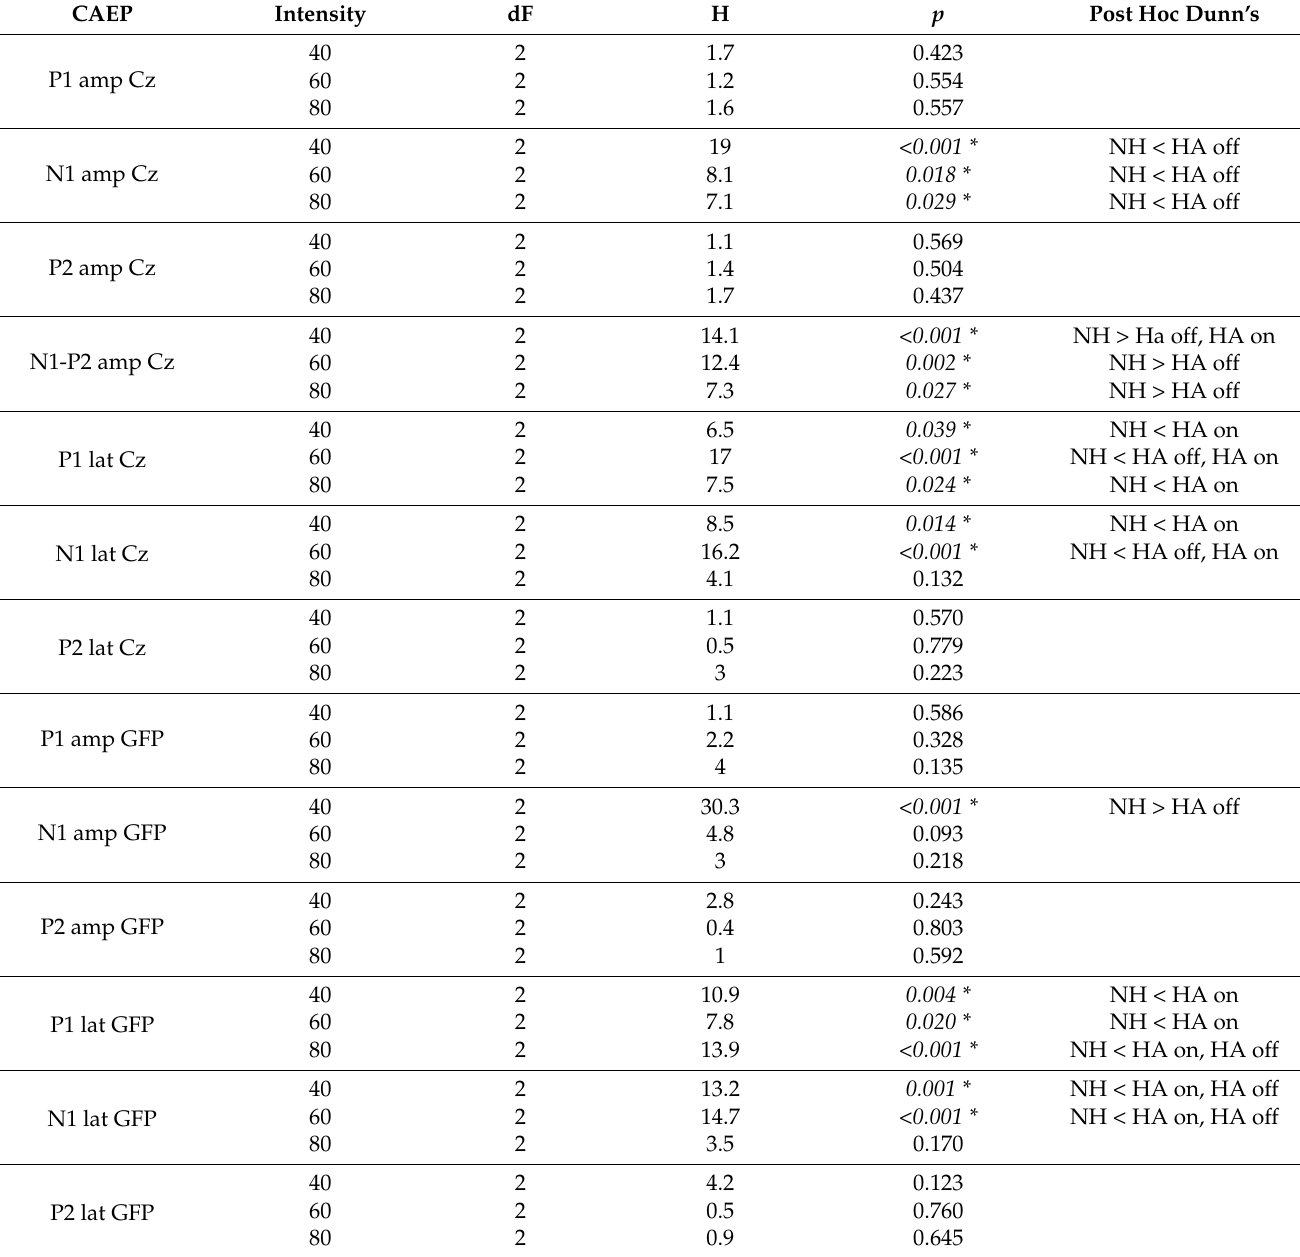
Table 5. Results of Kruskal–Wallis ANOVAs on ranked data. CAEP amplitude and latency data (aided and unaided) were compared across the NH and HA groups (aided or unaided) at Cz and for global field power (GFP) at each intensity. Significant effects are indicated by asterisks and italics; post hoc significant differences are shown after Bonferroni correction (adjusted p = 0.025) for multiple comparisons (Dunn) where NH data were compared to HA data with the HA on or